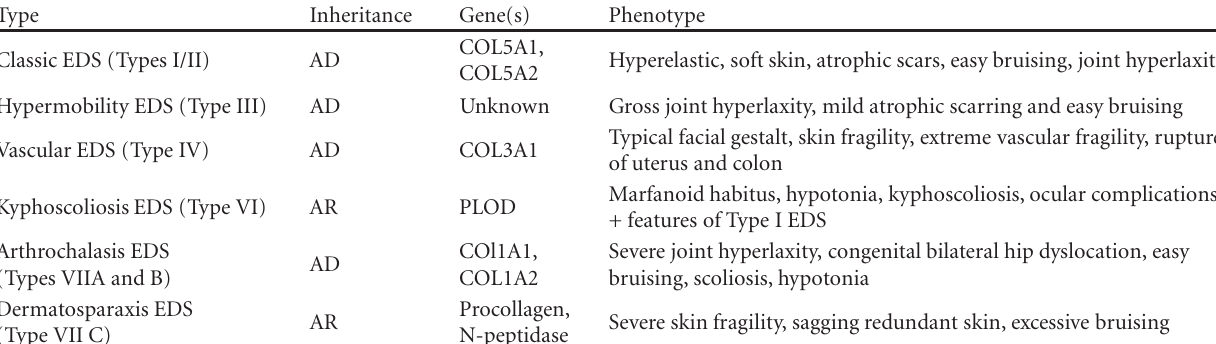
Table 1: Villefranche classification of Ehlers-Danlos syndrome